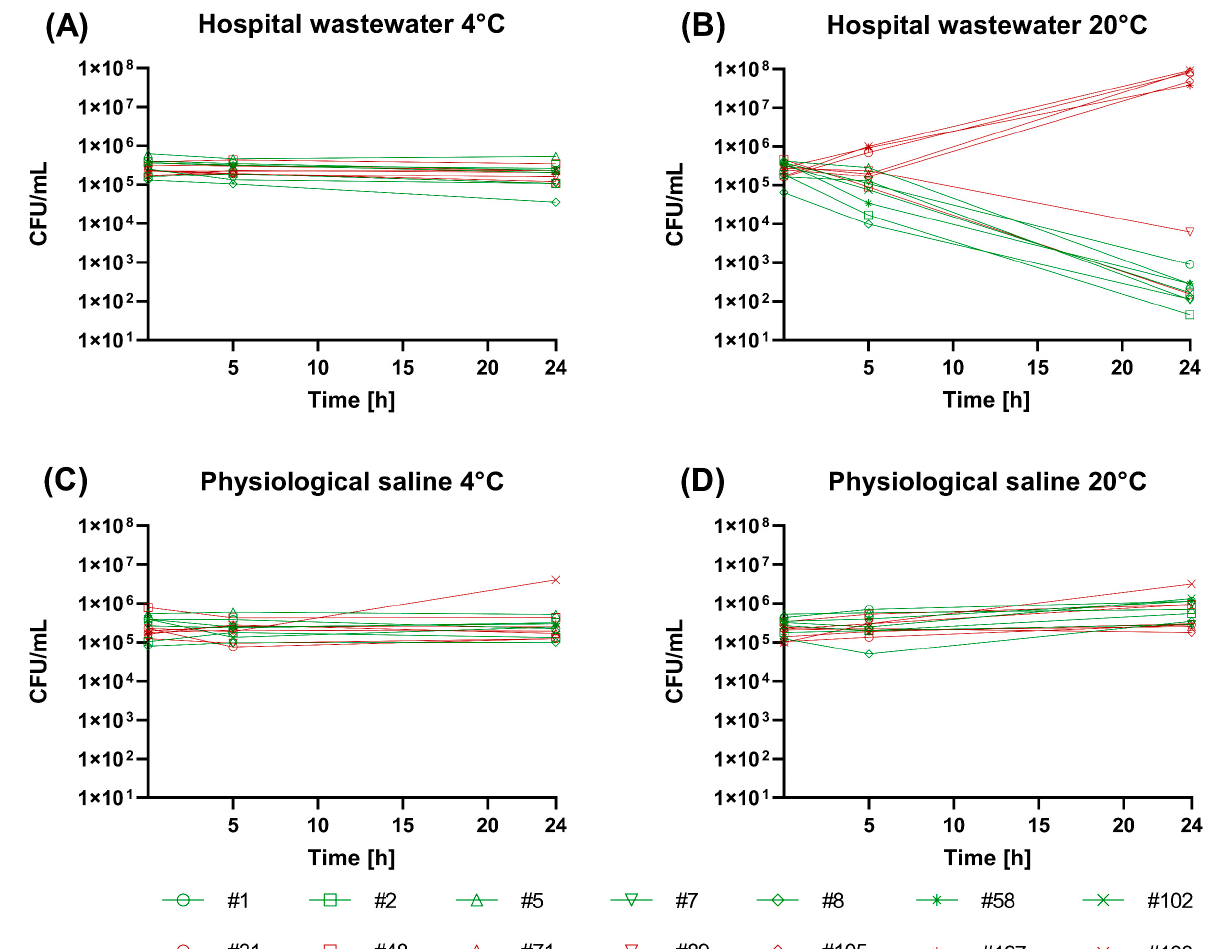
Figure 1. Time-kill assay of antibiotic-susceptible (green) and multi-resistant (red) E. coli strains. The individual strains (denoted by different numbers and symbols) were exposed to either hospital wastewater ( A , B ) or physiological saline ( C , D ) at 4 ◦ C ( A , C ), mimicking conditions that can be obtained during wastewater sampling, or at 20 ◦ C ( B , D ), identical to the conditions used by Kraupner et al. [22]. CFUs were assessed on MH agar after 5 h and 24 h incubation as well as at the start of the experiment (0 h). The value for strain #89 at 5 h in ( B ) is a minimum assessment since there was overgrowth on the MH plates with the highest inoculated dilution.